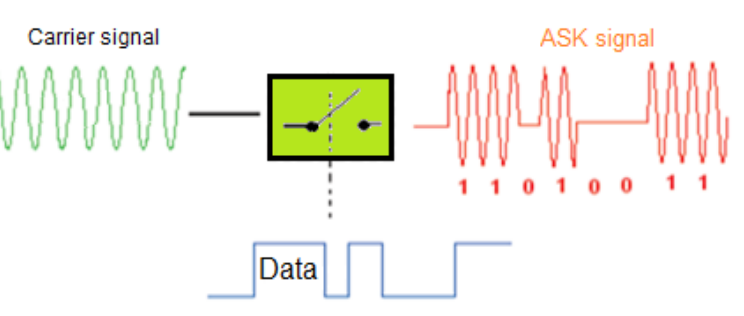
Figure 4. Principle of ASK